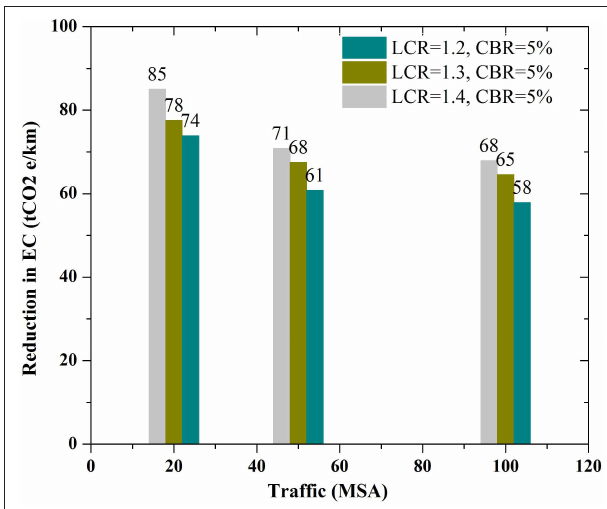
FIGURE 8 | Variation of reduction in EC with traffic for a subgrade CBR of